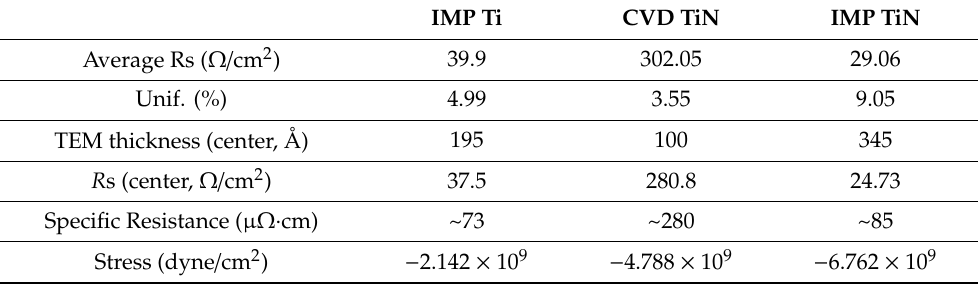
Table 1. Sheet resistance ( R s) and specific resistance value ( ρ ) for each